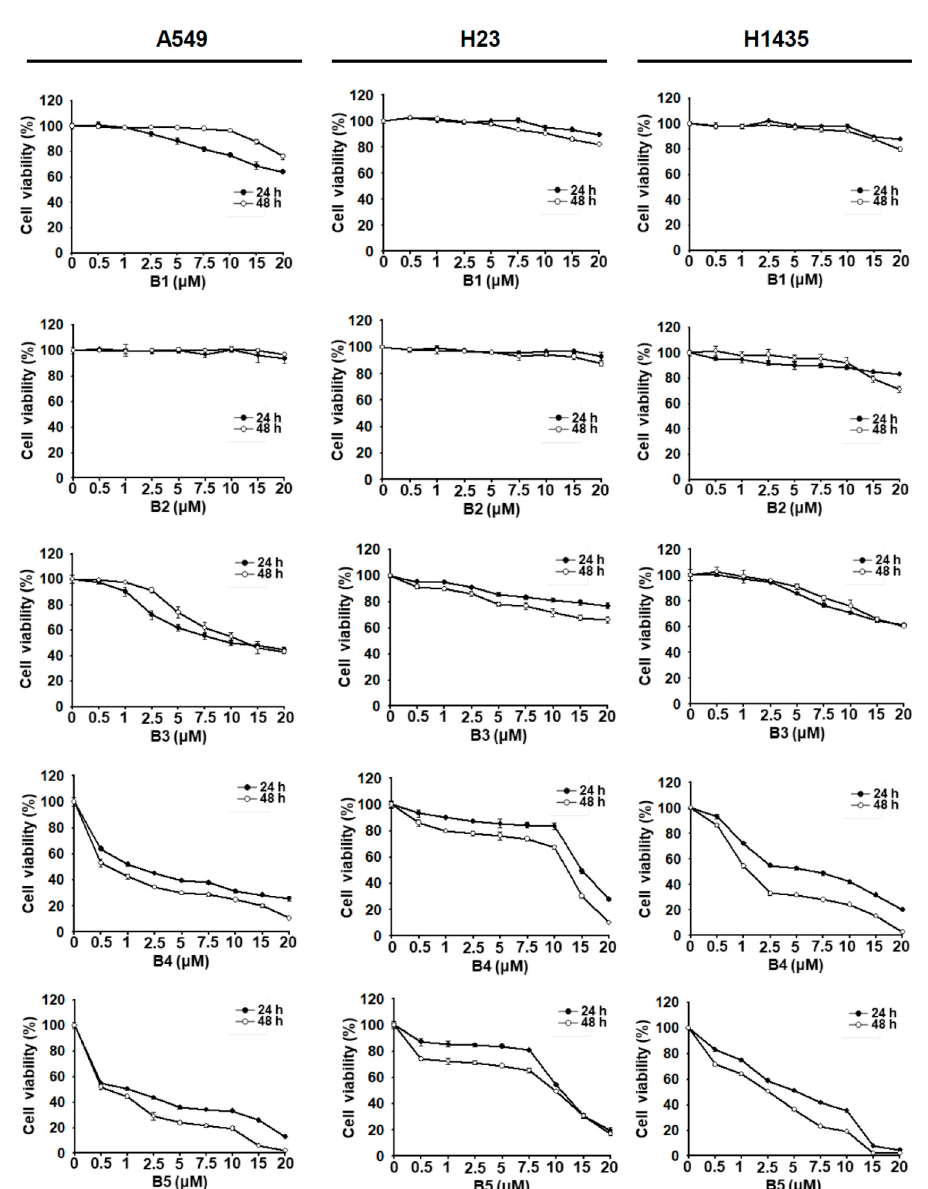
Figure 2. Berberine as well as berberrubine and its derivatives regulated the survival of NSCLC cells. A549, H23, and H1435 cells were treated with a control medium or a medium containing specific agents in various concentrations. Cell viability was tested using the CCK-8 assay at 24 h and 48 h after incubation.